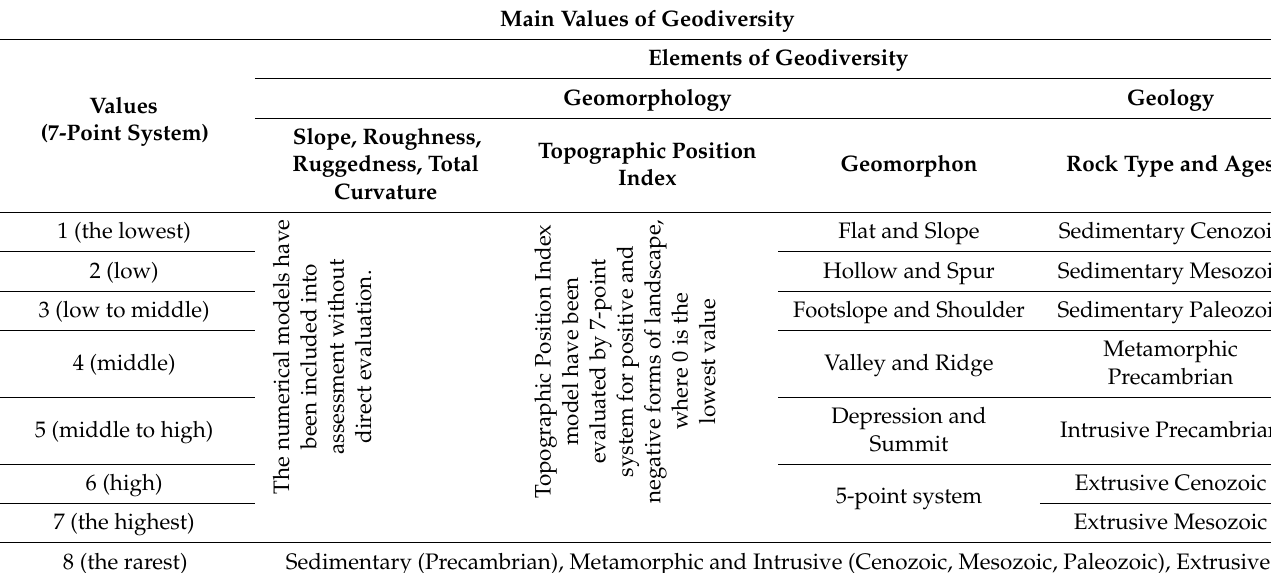
Table 1. The value systems for geodiversity assessment of Coromandel